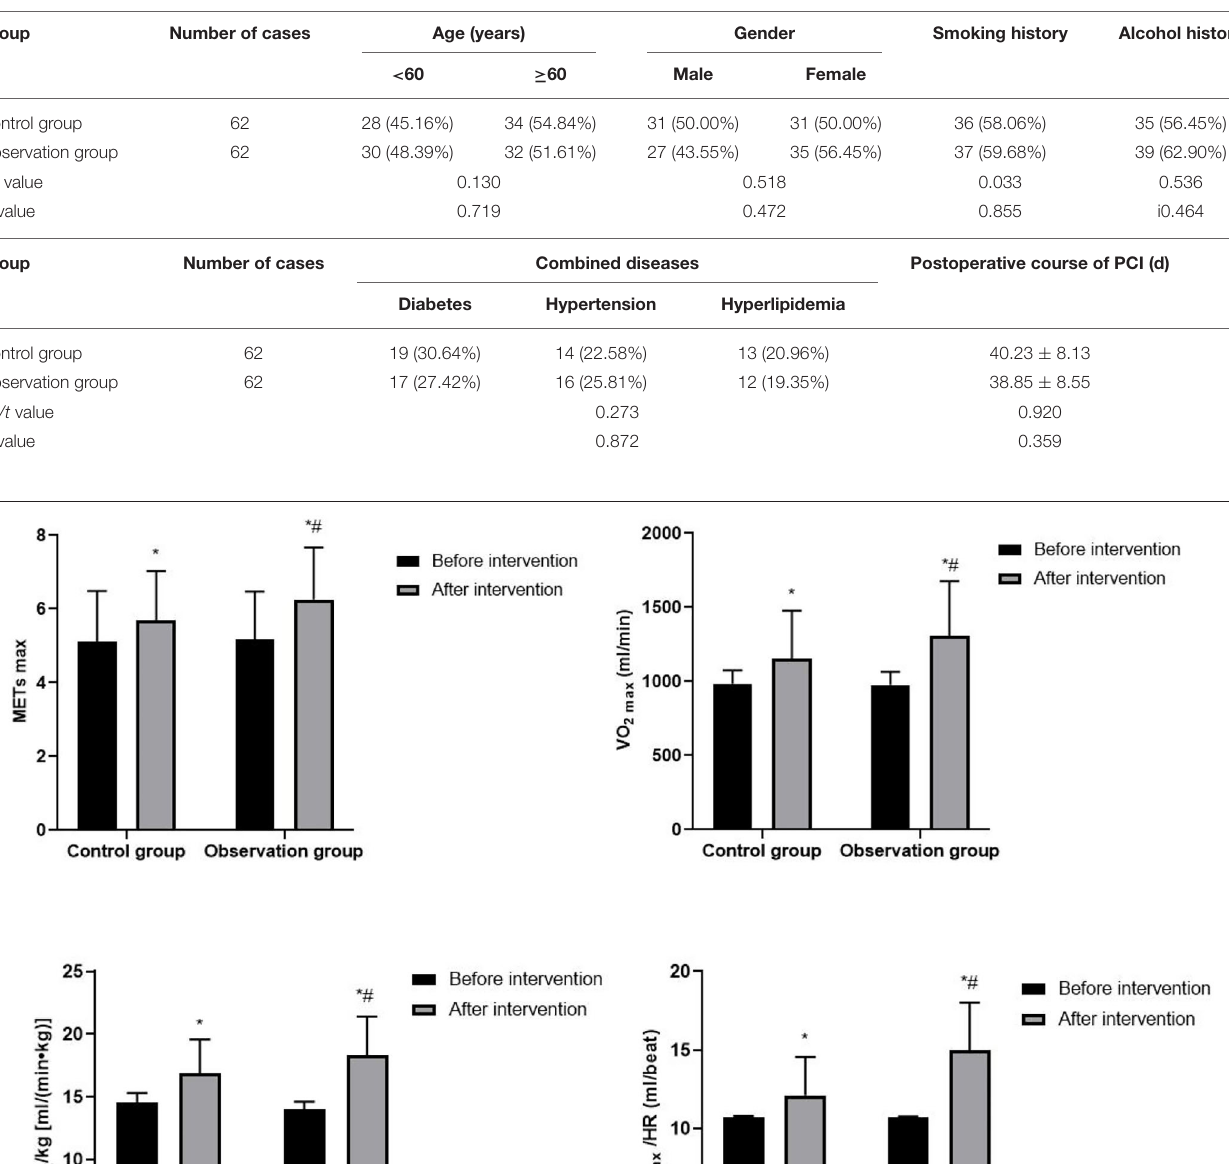
flow, improve the shape and function of vascular endothelial cell, repair damaged vascular endothelium, and inhibit the development of atherosclerosis. (4) Accelerate blood flow, reduce blood viscosity, improve microcirculation while increasing the oxygen uptake capacity of the body. (5) When the balloon is